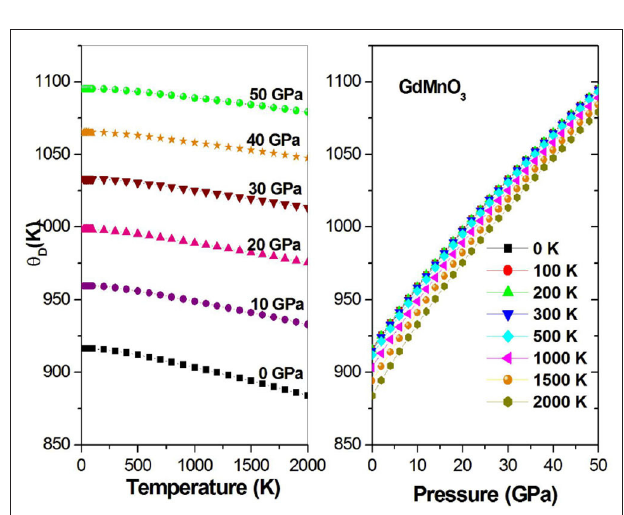
FIGURE 9 | Grüneisen constant γ as a function of the temperature (pressure) at different given pressures (temperatures).